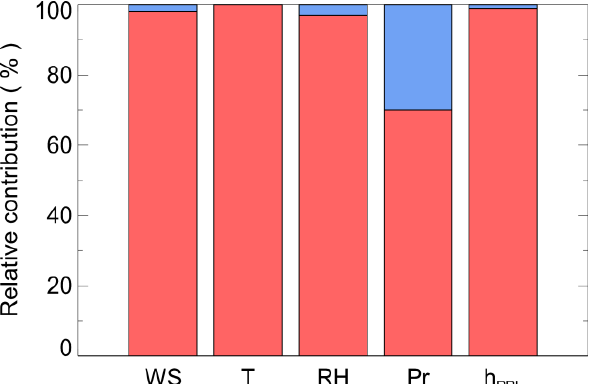
Figure 12. Relative contribution of the di ff erence on chemical response by meteorology (term A; red) and the meteorological di ff erence (term B; blue) within the multiple linear regression equation. The meteorological variables are 10-m wind speed ( WS ), 2-m temperature ( T ), relative humidity ( RH ), precipitation ( Pr ), and PBL height ( h PBL ).